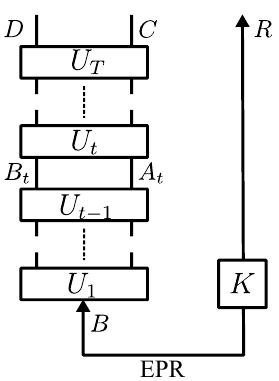
Figure 7 . Discretized time evolution of a large AdS black hole with long throat. K represents some complex unitary and A t are the con(cid:12)ned modes. R is far distant on the right-hand side. which disentangles the outgoing mode D from the early radiation R . This decoupling state of the black hole without using any degrees of freedom from the early radiation R